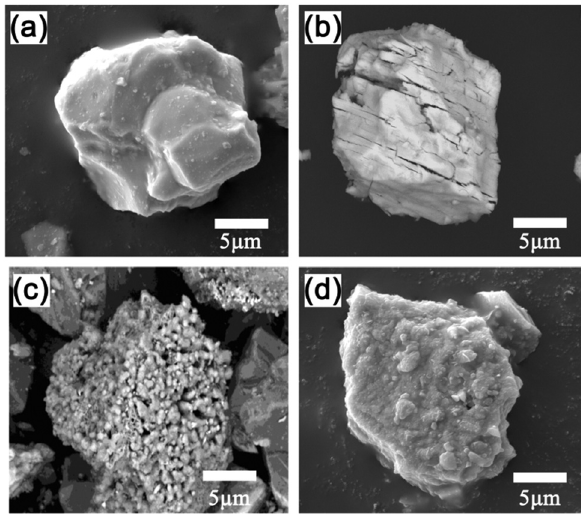
Figure 6: SEM characterization of rare earth tailings before and after calcination: ( a ) original mine tailings, ( b ) tailings calcined at 500°C, ( c ) tailings calcined at 600°C, ( d ) tailings calcined at